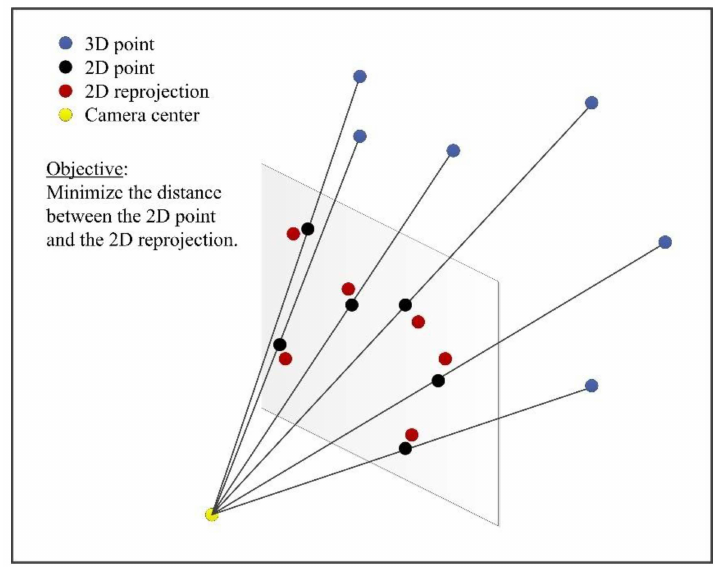
Figure 3. The reprojection